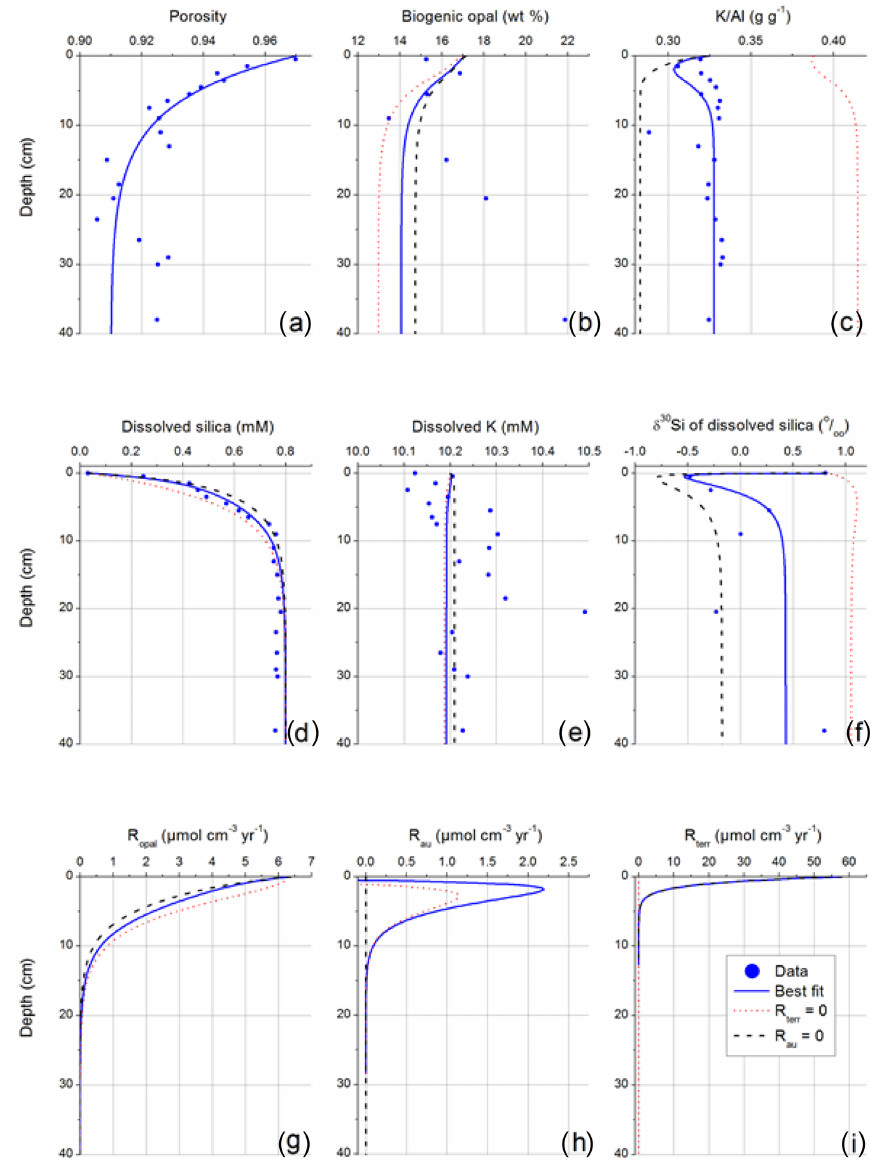
Figure 6. Data and model results for OMZ core: (a) porosity, (b) biogenic opal concentration in solid phase, (c) K / Al ratio in solid phase, (d) dissolved Si concentration in pore fluids, (e) dissolved potassium in pore fluids, (f) isotopic composition of dissolved Si, (g) rate of biogenic opal dissolution, (h) rate of authigenic phase precipitation, and (i) rate of terrigenous-phase dissolution. Sensitivity tests of the model are indicated by setting the dissolution of terrigenous clay phases to zero (dashed red line) and setting the precipitation of authigenic phases to zero (dashed black line). The model values agree best with the measured data when both processes take place (blue line, best